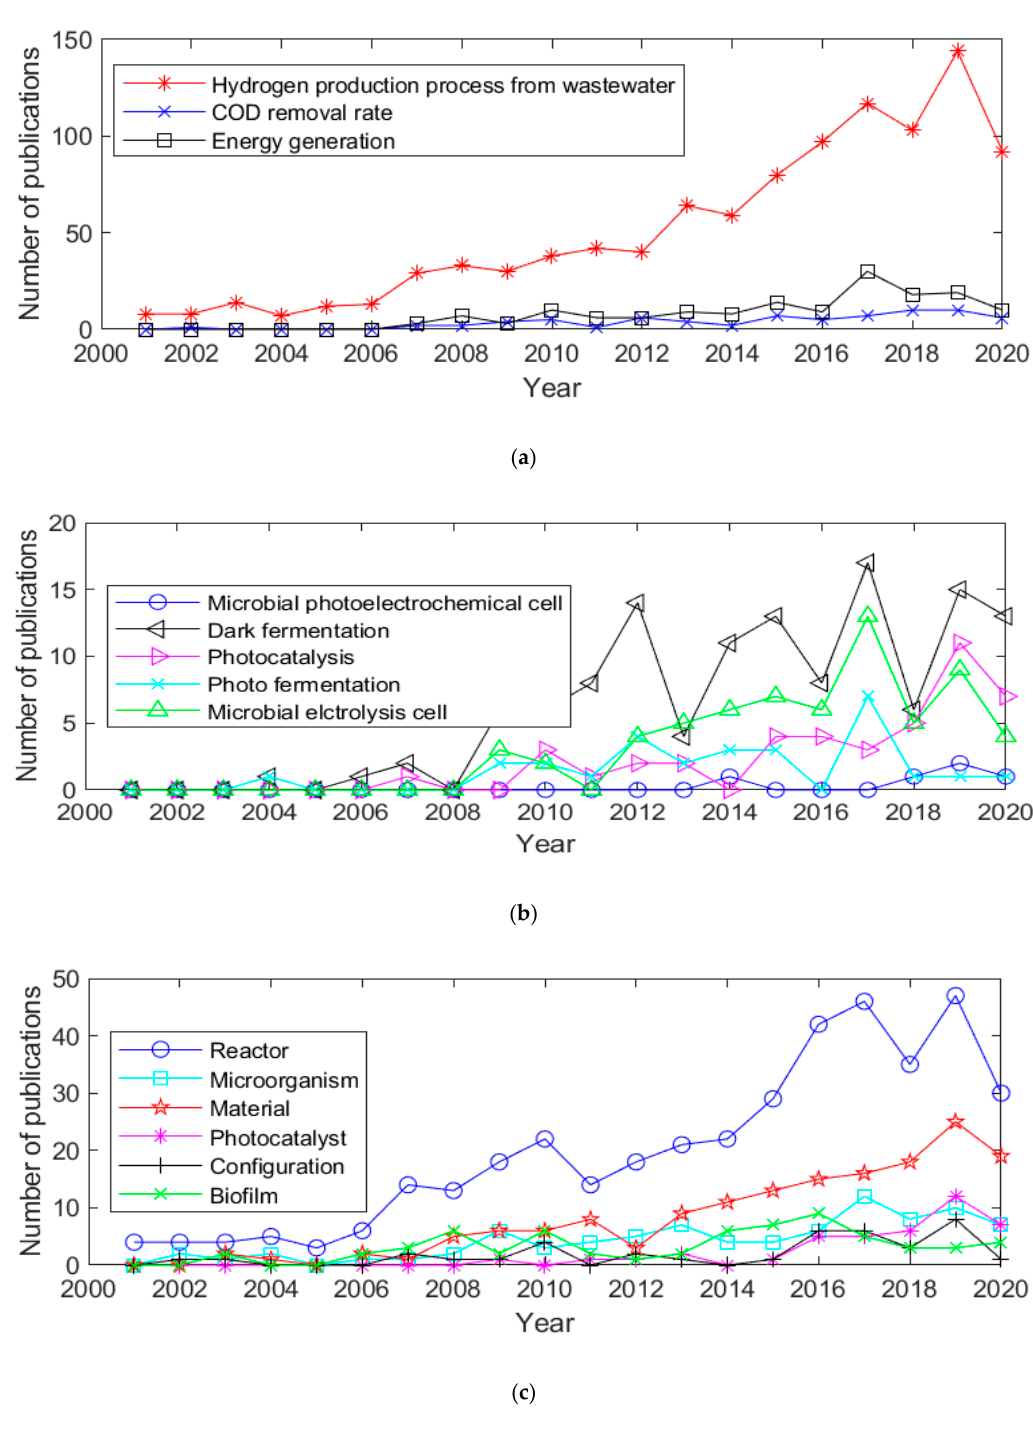
Figure 1. Comparative publication output for selected search terms per year; ( a ) H 2 production process, energy generation and COD reduction rate. ( b ) Microbial photoelectrochemical cell, dark fermentation, photocatalysis, photo fermentation and microbial electrolysis cell. ( c ) Reactor, microorganism, material, photocatalyst, configuration and biofilm.